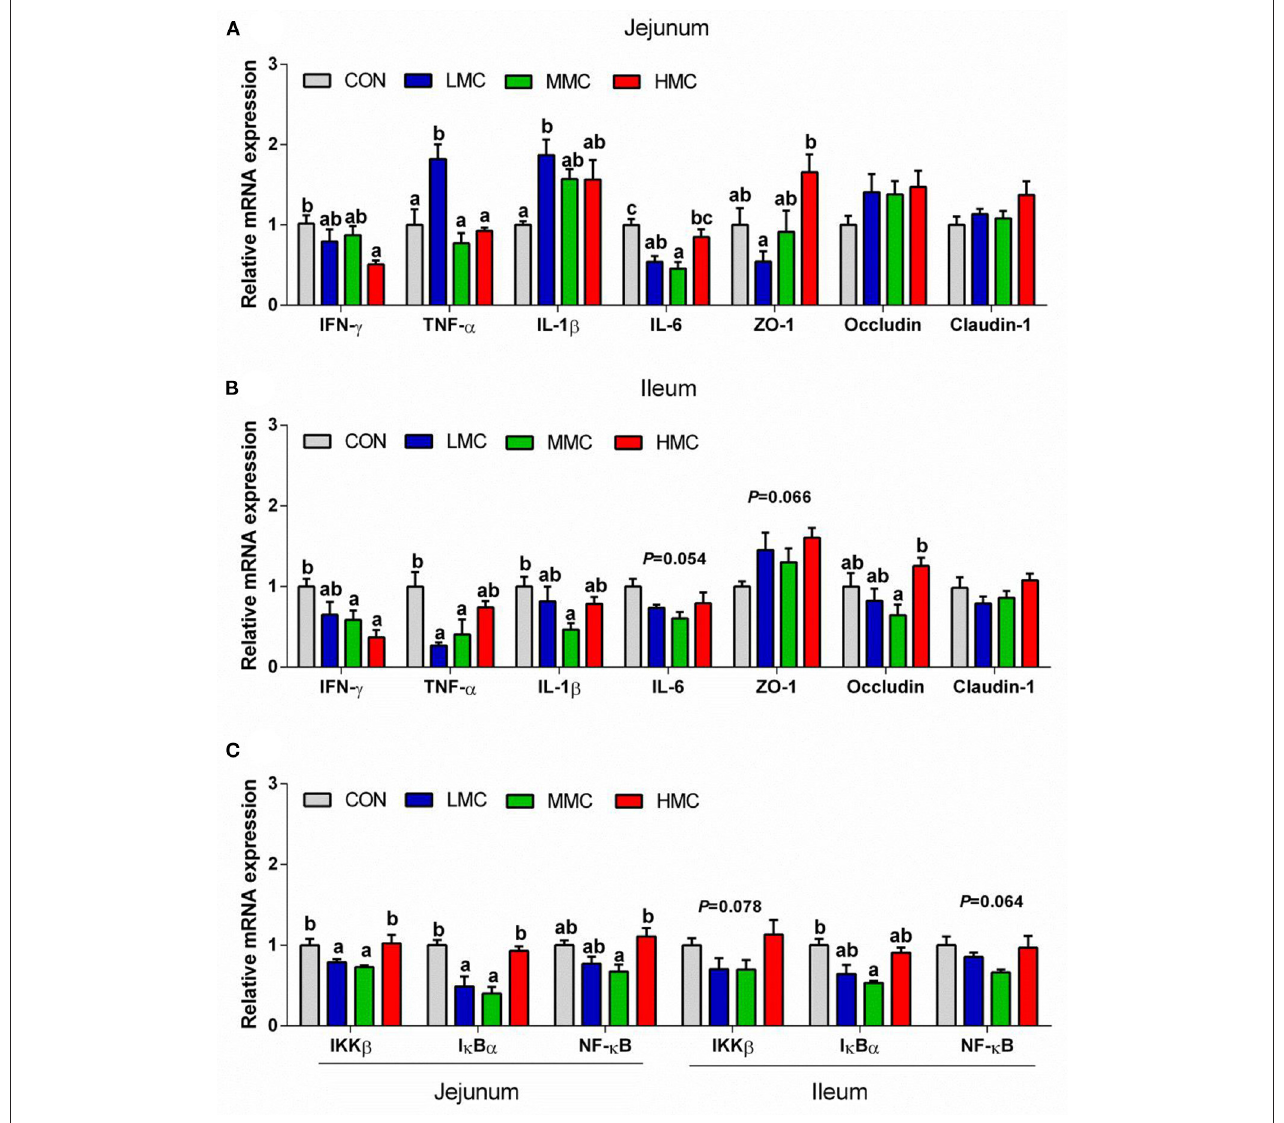
FIGURE 2 | Gene expression levels associated with the proinflammatory factors (IFN- γ , TNF- α , IL-1ß, and IL-6) and tight junction proteins (ZO-1, occludin, and claudin-1) of jejunum (A) and ileum (B) , and NF- κ B signaling pathway in the jejunum and ileum tissues (C) of pigs fed the Moutan cortex radicis diet. CON, control group, basal diet without antibiotics; LMC, the control diet + 2,000 mg/kg Moutan cortex radicis ; MMC, the control diet + 4,000 mg/kg Moutan cortex radicis ; HMC, the control diet + 8,000 mg/kg Moutan cortex radicis . Data are expressed as means ± SEM ( n = 6). Means with different superscripts in the columns are significantly different ( P <